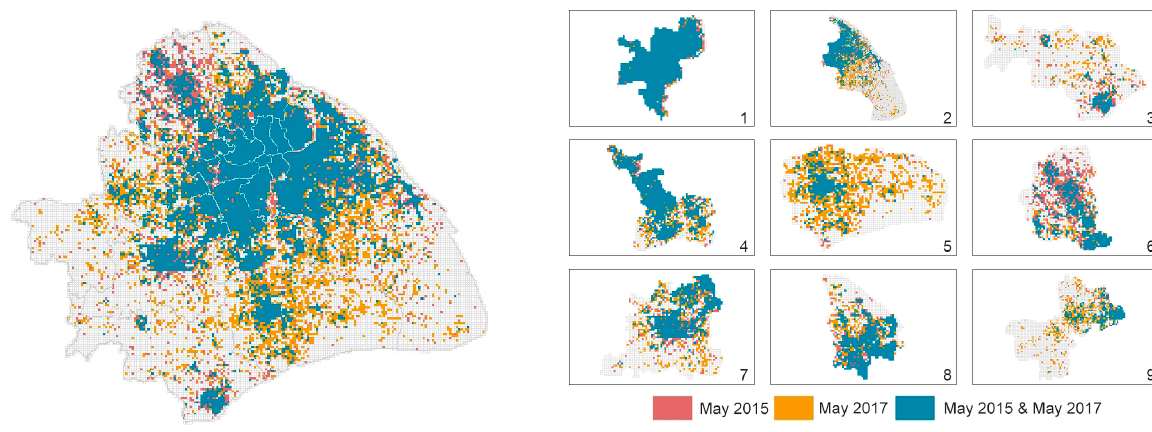
Figure 9. Distribution of the pick-up spots. Oriented top to bottom, from left to right: (1) urban center; (2) Pudong New Area; (3) Jinshan District; (4) Minhang Area; (5) Fengxian District; (6) Jiading District; (7) Songjiang District; (8) Baoshan District; (9) Qingpu District.